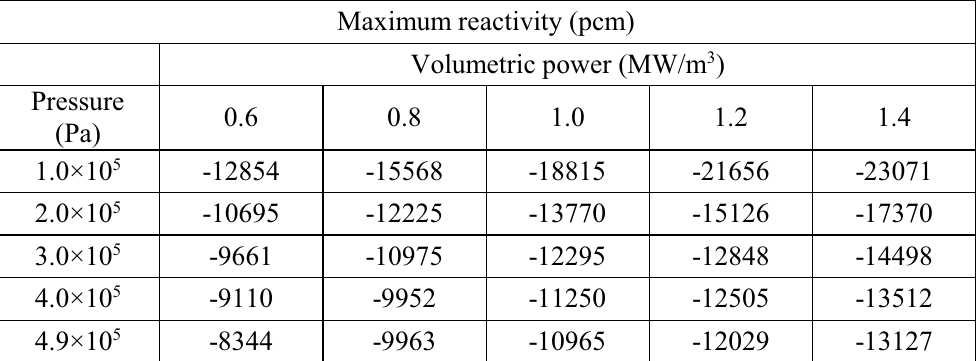
Figure 5: Top: Behavior of the void fraction. Bottom: validation of the ANN with respect to APOLLO2 for the evolution of the system reactivity. Table II: Summary of the simulation